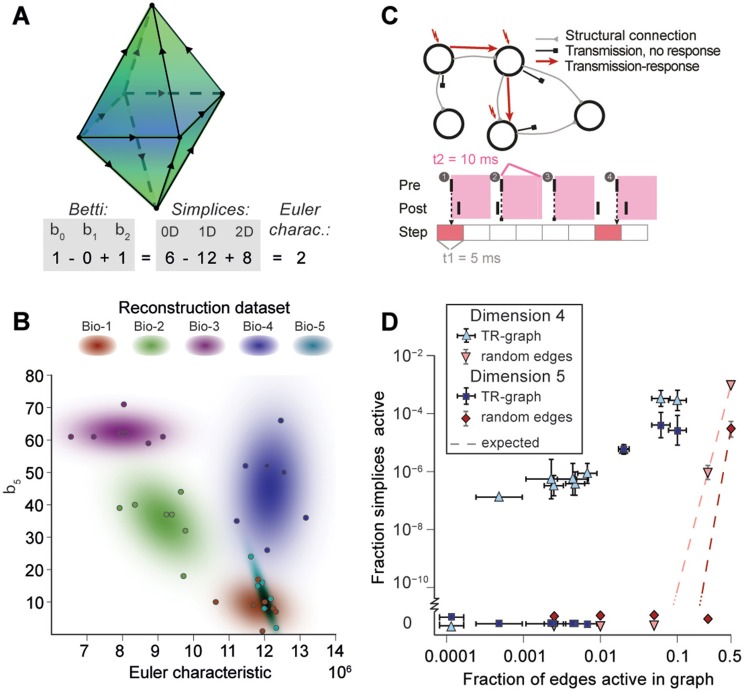
(A) Example of the calculation of the Euler characteristic of a directed flag complex as an alternating sum of Betti numbers or simplex counts. (B) Euler characteristic against the highest non-zero Betti number (β5) for seven instances of reconstructed microcircuits based on five different biological datasets (Bio 1-5). (C) Top: The transmission-response (TR) graph of the activity of a microcircuit is a subgraph of its structural connectivity containing all nodes, but only a subset of the edges (connections). Bottom: An edge is contained if its presynaptic neuron spikes in a defined time bin and its postsynaptic neurons spikes within 10 ms of the presynaptic spike. (D) Fraction of edges active against fraction of high-dimensional simplices active in TR graphs for various time bins of a simulation. Error bars indicate the standard deviation over 10 repetitions of the simulation. Blue triangles: 4-dimensional simplices, blue squares: 5-dimensional simplices. Red symbols and dashed lines indicate the results for choosing edges randomly from the structural graph and the number expected for random choice, respectively.